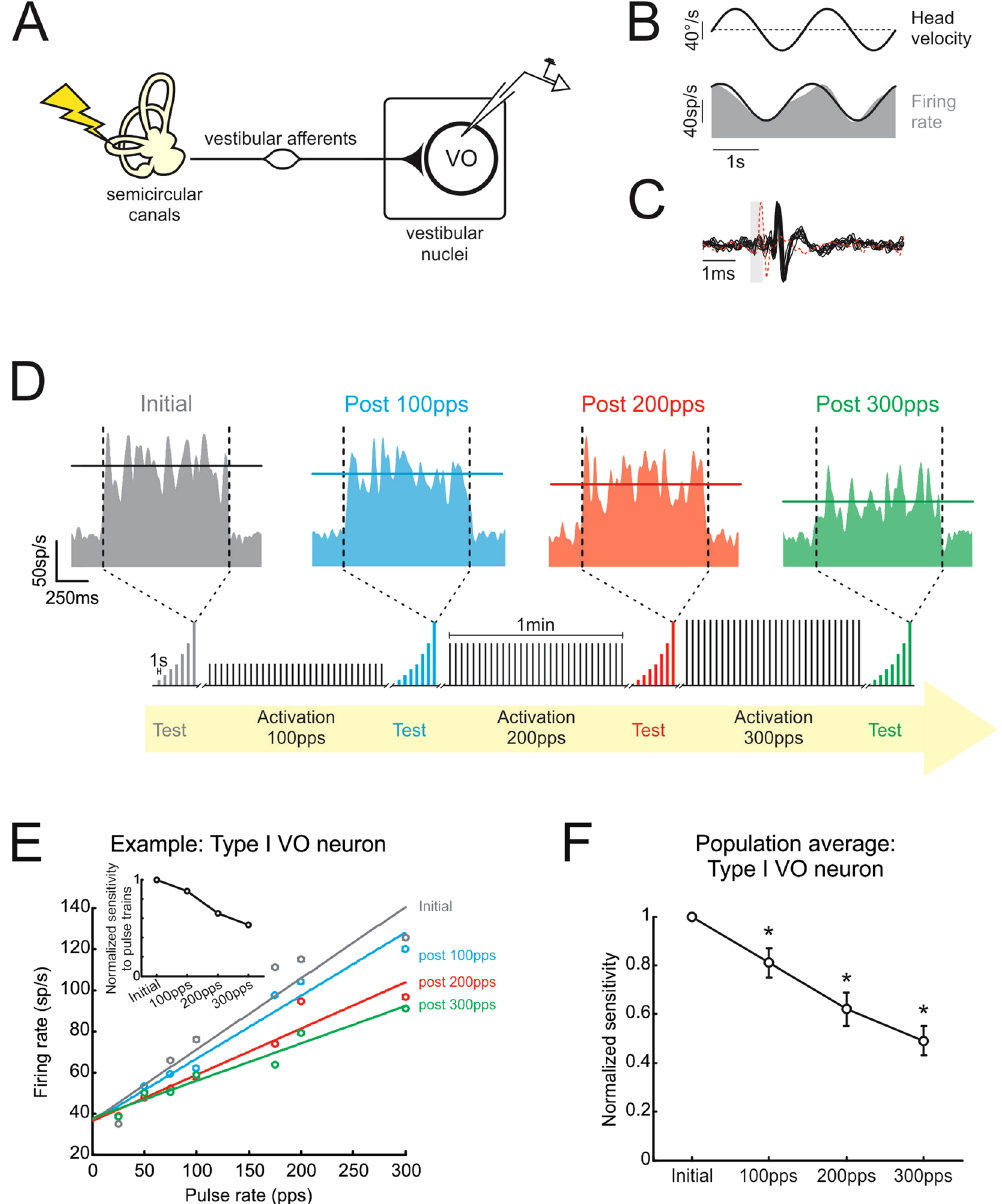
Figure 2. Type I VO neurons are attenuated following activation of the vestibular nerve. ( A ) Recordings were made from VO neurons receiving direct input from the vestibular nerve during stimulation of the horizontal semicircular canal. ( B,C ) Example type I VO neuron increased its firing as a function of ipsilateral head motion and reliably fired action potentials in response to individual pulses. The red trace shows a trial during which the neuron failed to fire an action potential because the pulse occurred during its refractory period. ( D ) Response of example type I VO neuron during pulse trains delivered at 300pps during test stimuli before and after activation of the vestibular nerve. Inset below shows timeline of stimulation protocol. ( E ) Firing rate as a function of pulse rate measured during test stimuli applied before and after activation of the vestibular nerve. Inset shows slope of linear regression between firing rate and pulse rate before and after activation of the vestibular nerve for example neuron. ( F ) Normalized sensitivity to test stimuli for population of type I VO neurons is attenuated following activation of the vestibular nerve. Error bars represent ±